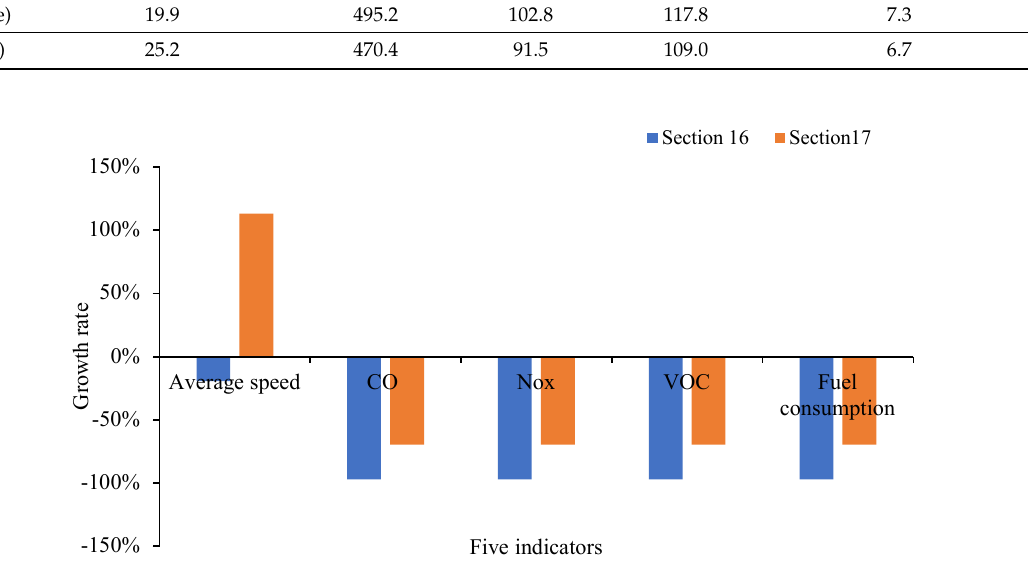
Table 6. Comparison of results of the sections.